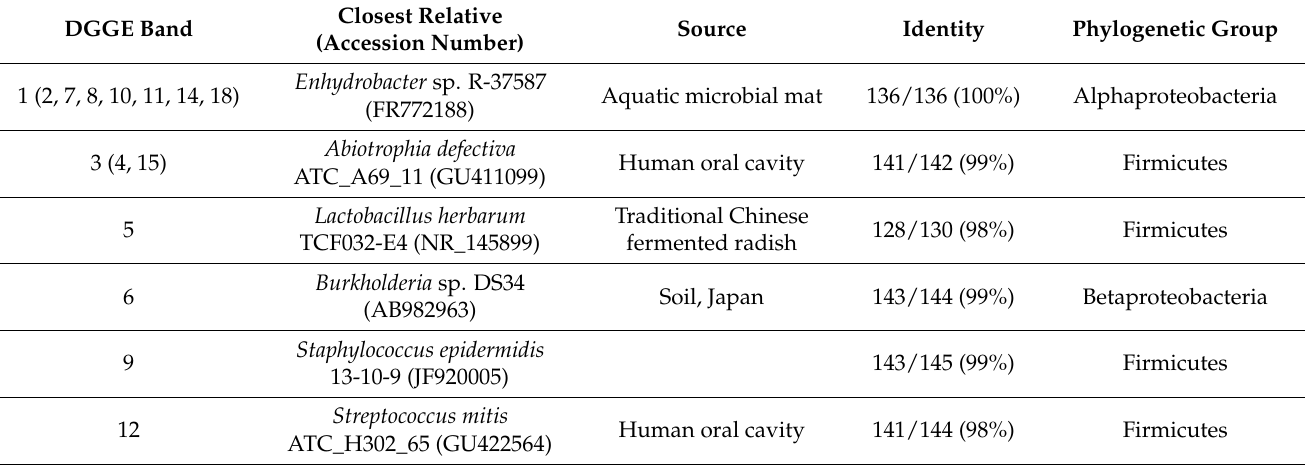
Table 1. Sequencing analysis of major denaturing gradient gel electrophoresis (DGGE)